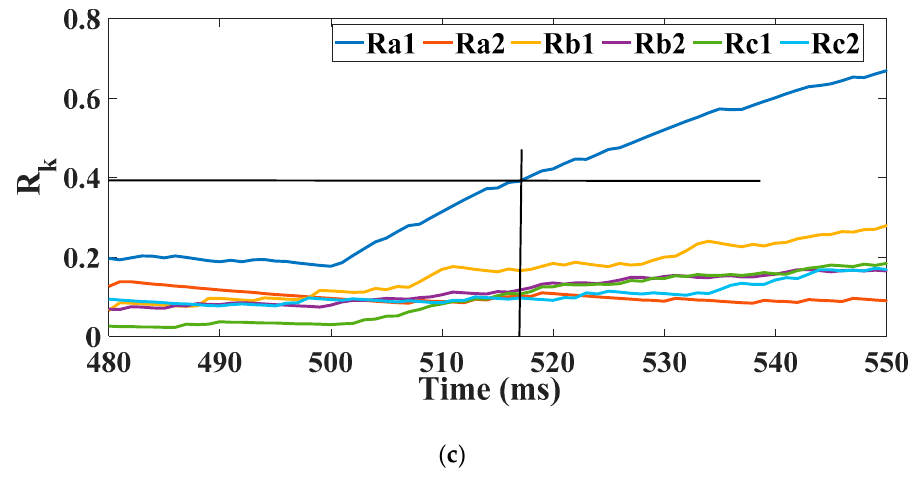
Figure 6. OPF test: ( a ) Phase current (a1); ( b ) Fault indices; ( c ) Detection time (zoom in of the fault indices).